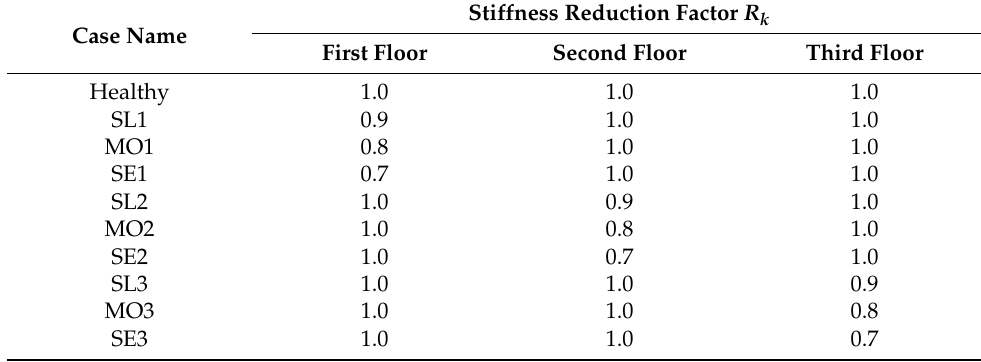
Table 2. Ten simulation setups comprising the ten classes.